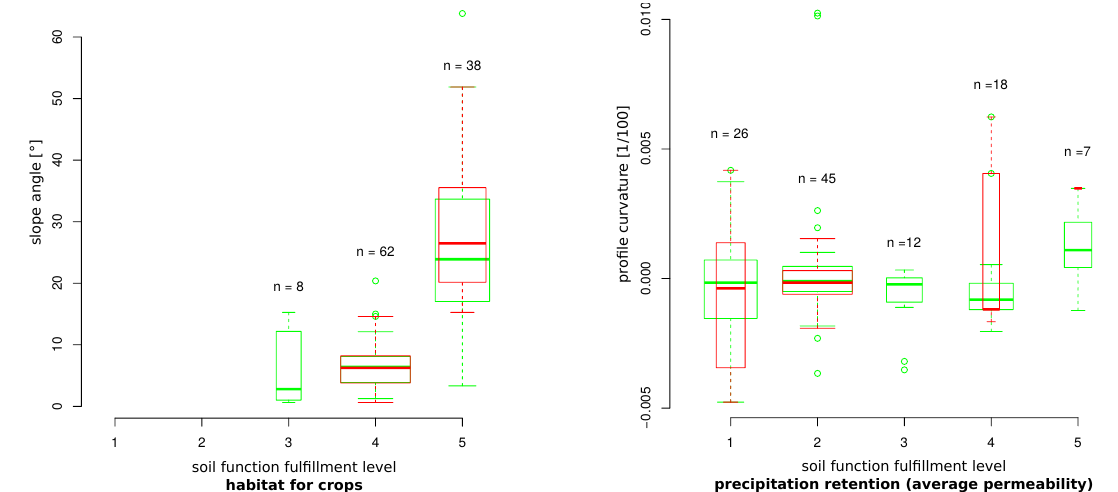
Figure 7. Box plots representing the distribution of the slope angles and profile curvatures of the soil profile sites classified according to the levels of fulfillment of the functions as a habitat for crops, and precipitation retention, respectively. The green box plots represent the distribution of fulfillment levels as assessed by the SEPP tool, whereas the red box plots represent the distribution as predicted by a SVM